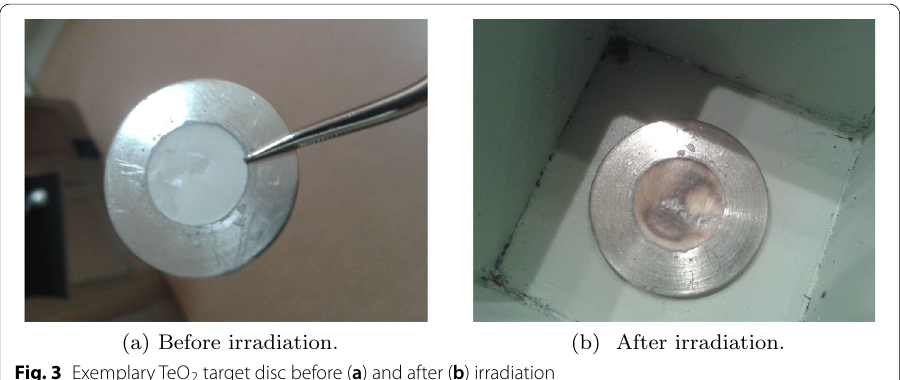
Fig. 3 Exemplary TeO 2 target disc before ( a ) and after ( b )